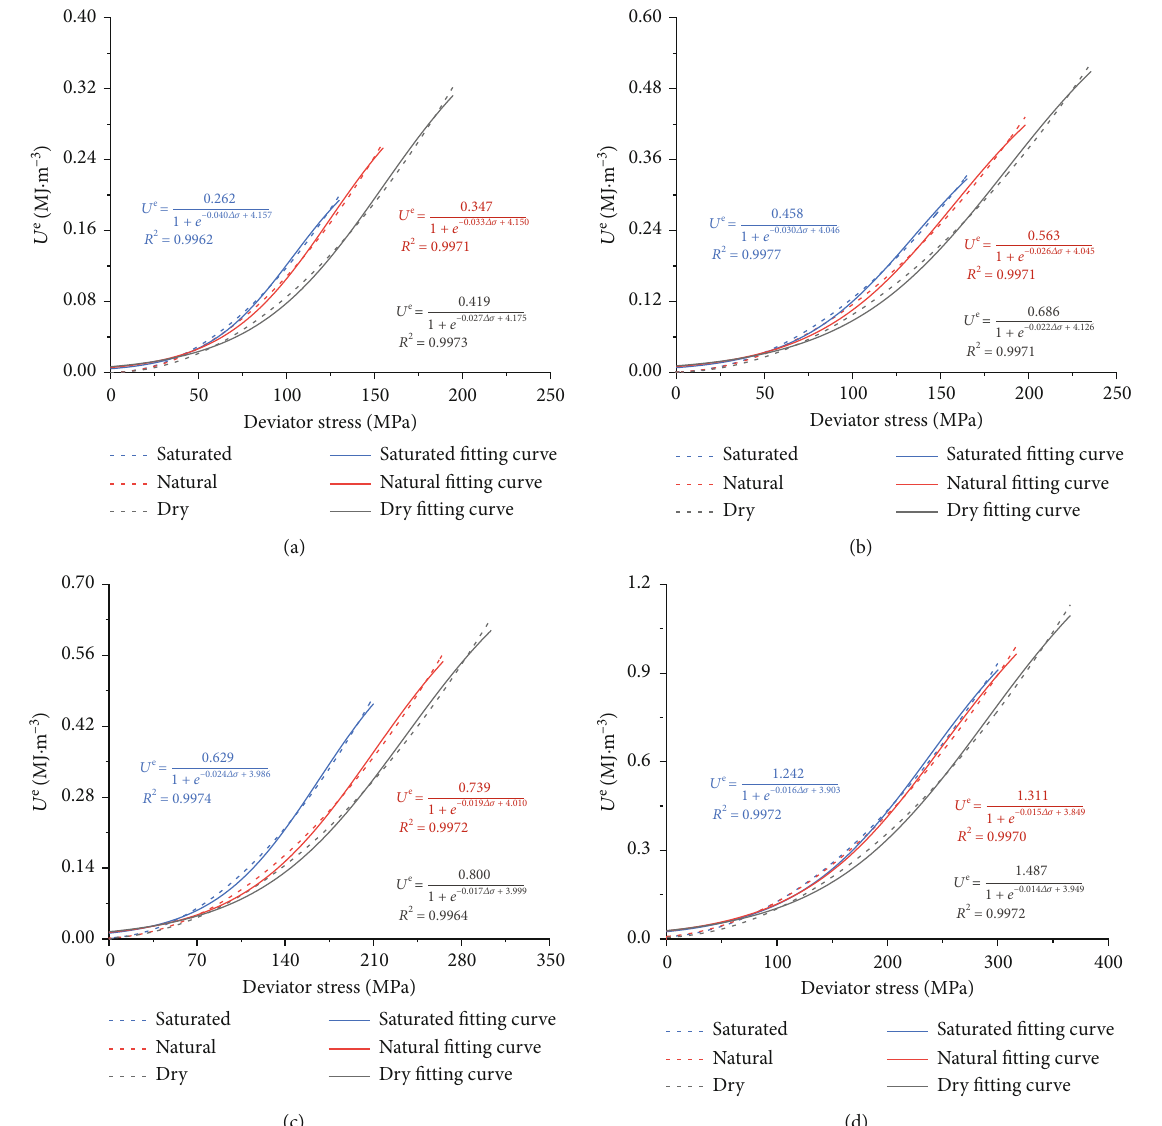
Figure 11: Relationship between U e and deviator stress in granite with three water content states under di ff erent con fi ning pressure and its nonlinear fi tting equation: (a) σ 3 = 0 MPa; (b) σ 3 = 5 MPa; (c) σ 3 = 10 MPa; (d) σ 3 = 20